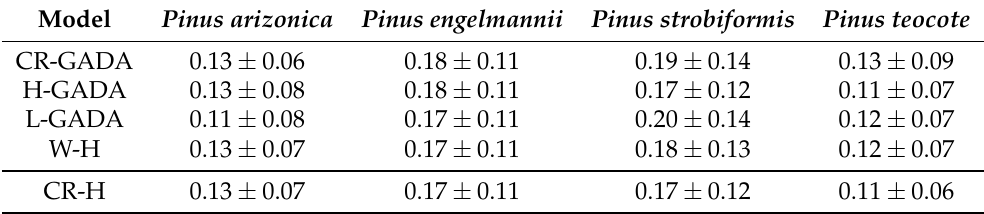
Table 4. Mean absolute percentage error (MAPE) and respective standard deviation results for each species and model considered.